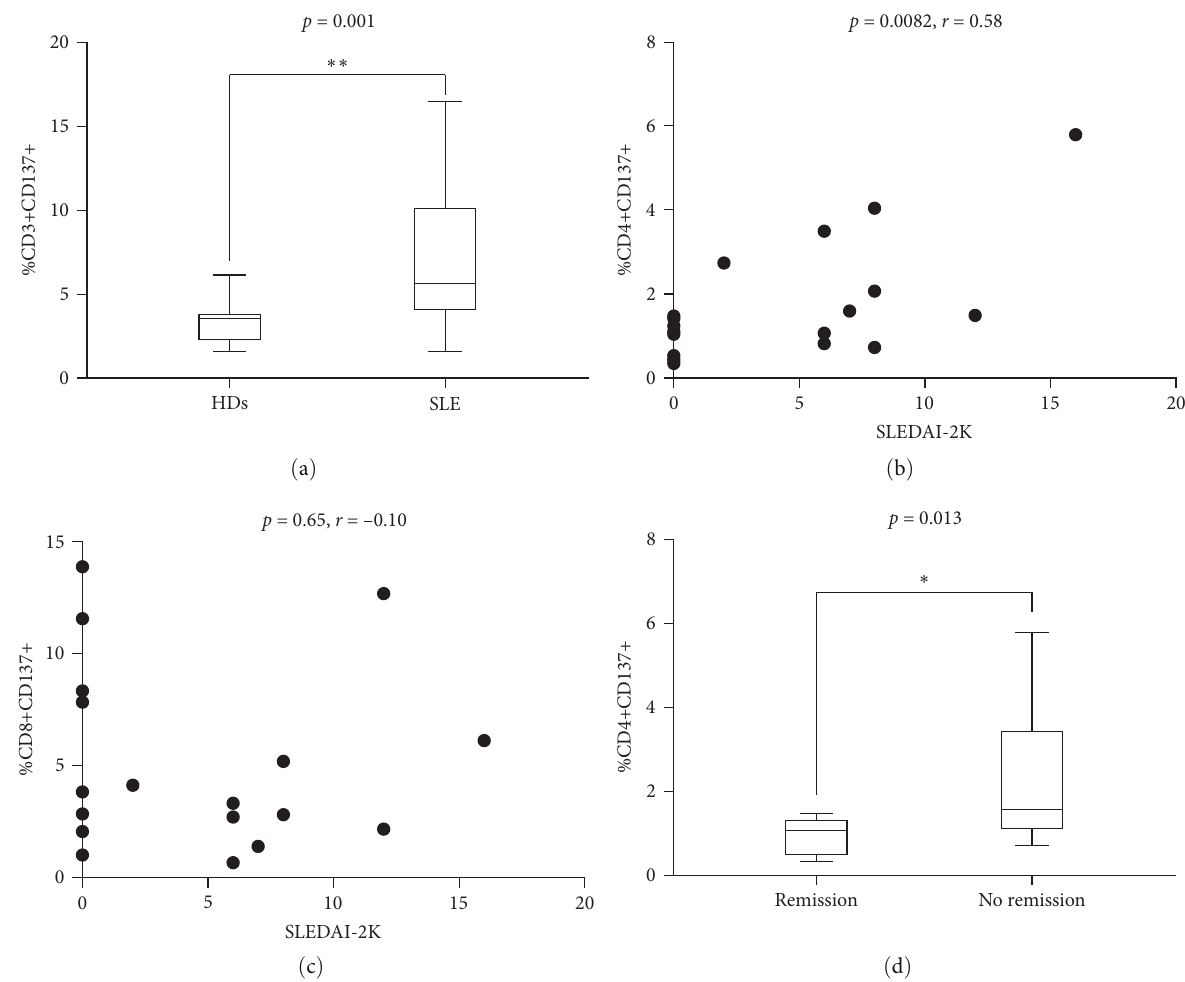
F IGURE 1: (a) Comparison of % CD3+CD137+ in HDs and SLE patients; (b) correlation between disease activity and % CD4+CD137+; (c) correlation between disease activity and % CD8+CD137+; (d) comparison of % CD4+CD137+ SLE patients in remission versus no remission